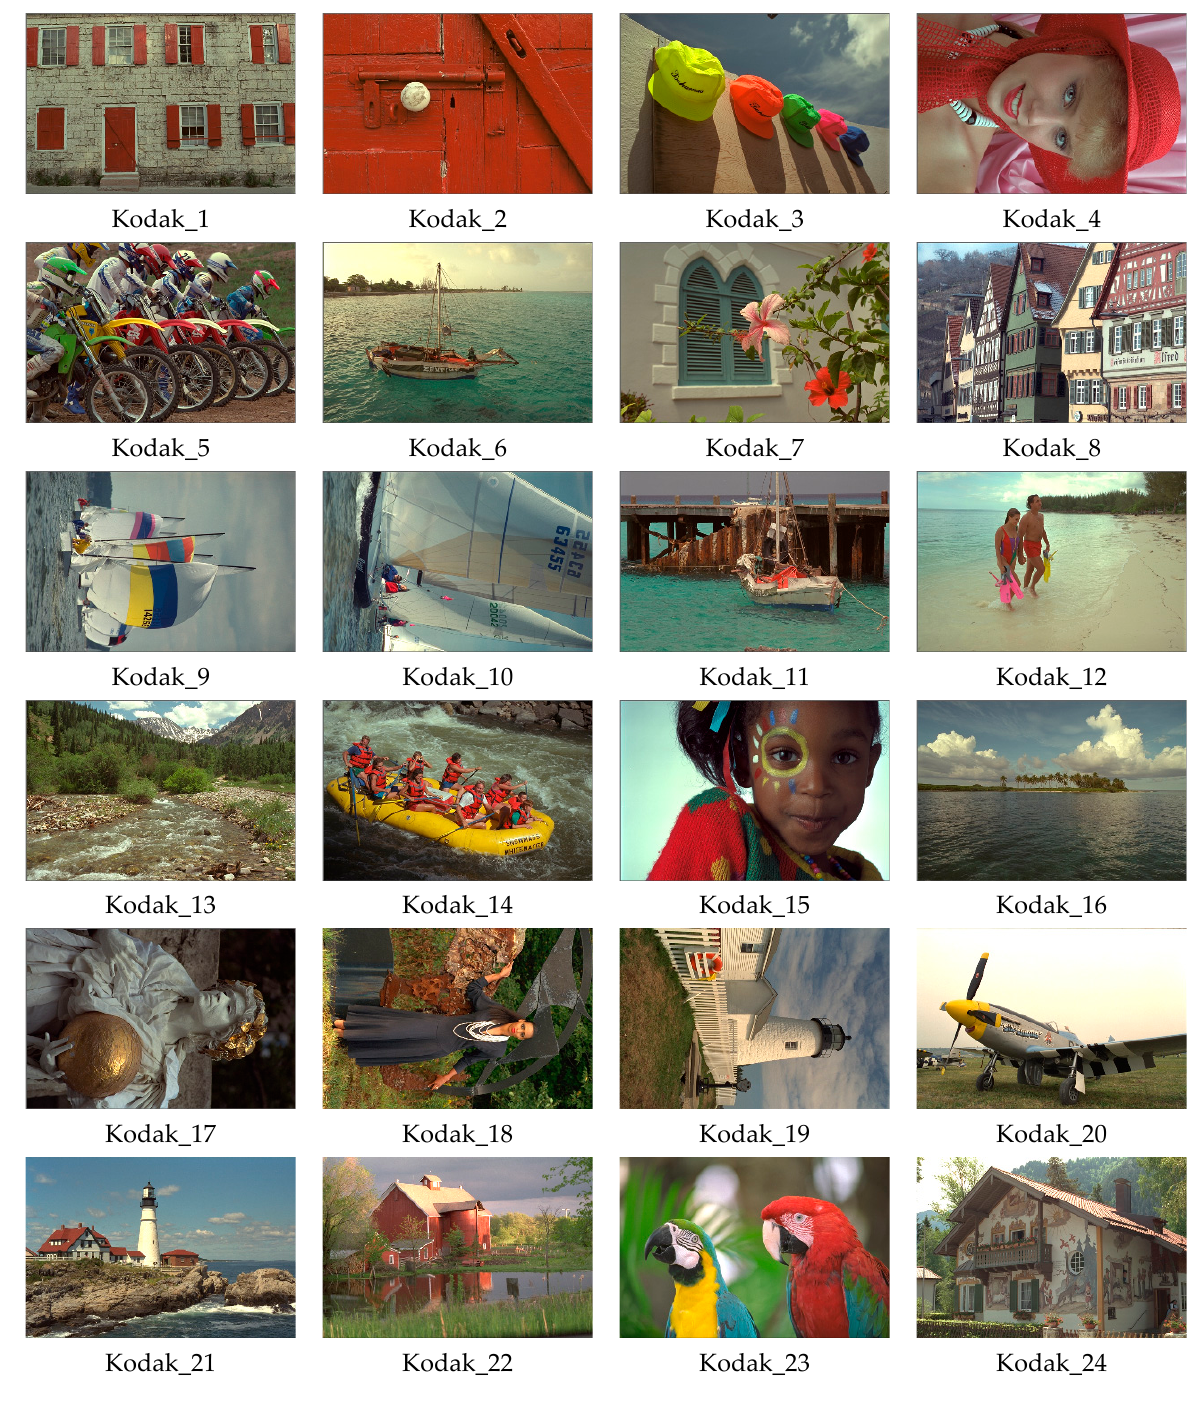
Figure 13. Kodak 24 images [24].